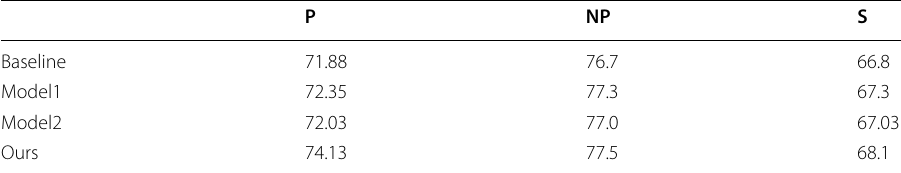
Table 4 Ablation analysis of the proposed tracker on the LaSOT dataset P